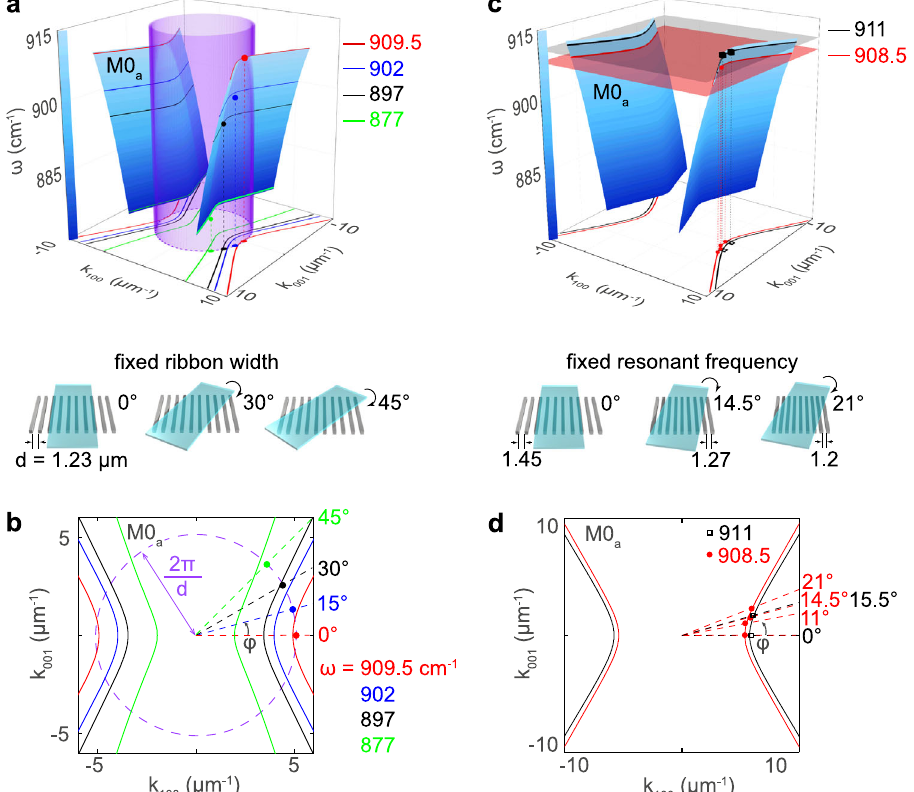
Fig. 4 Probing the dispersion surface of the M0 a PhP mode. a Analytical dispersion surface of the M0 a PhP mode (blue hyperboloid) when crossed by a surface (purple cylinder) representing a constant momentum. The color dots represent the positions of the measured resonant peaks (from Fig. 2d) for the same α -MoO 3 slab and metal grating twisted at different angles, φ . b , d Isofrequency curves for the M0 a mode at different frequencies ω . c Analogous dispersion surface as in ( a ), but crossed by planes of fi xed frequencies ( ω ¼ 908 : 5 , and 911 cm − 1 ). The points mark the peak positions for metal lattices with different widths of the air gaps d and twist angles φ . The thicknesses of the fl akes in ( a , b ) and ( c , d ) are 110 and 127.5 nm,